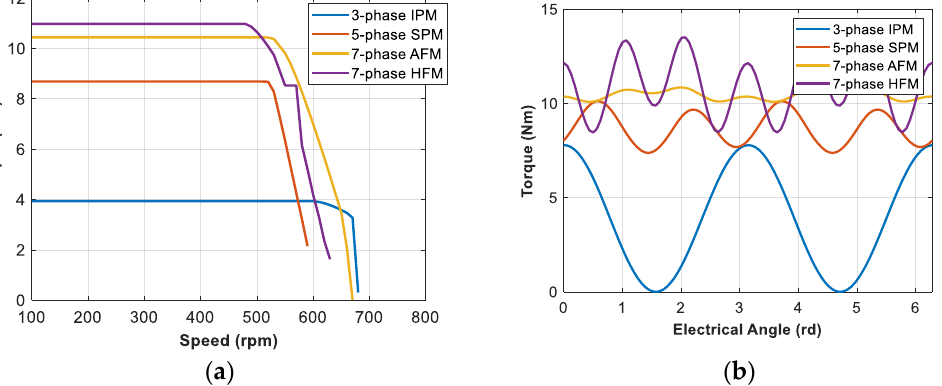
Figure 13. Torque characteristics in degraded mode of ( a ) torque-speed curves; ( b ) torques at low speed.